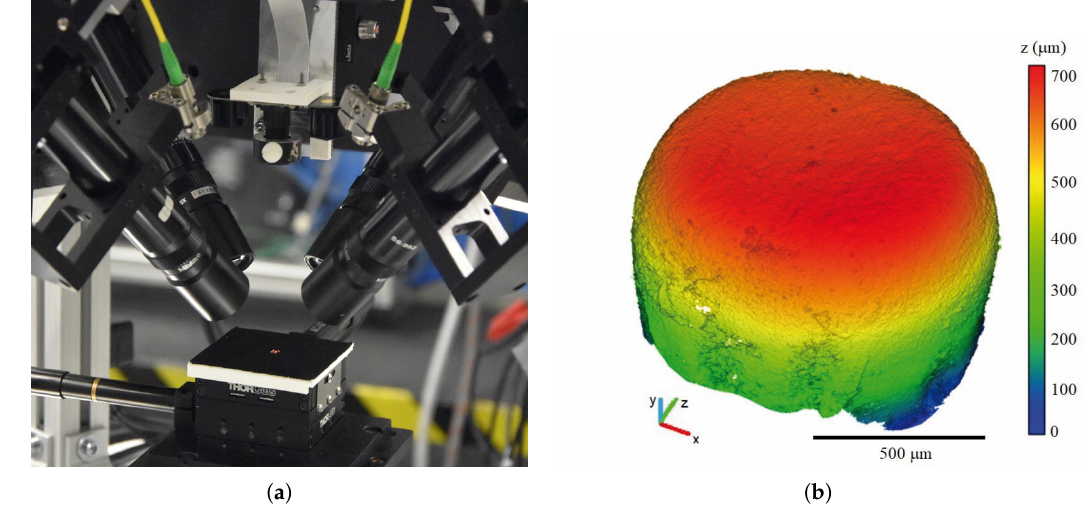
Figure 3. Digital holographic microscope for the inspection of micro cold formed micro cups: ( a ) The measurement system consists of 4 digital holographic microscopes to provide a full view of the top area of the object. ( b ) The measurement result shows a micro cup with diameter and height of approximately 1 mm. The lateral resolution is 2 µ m over an extended range of 700 µ m. The system can be used to quantify local imperfections, such as dents and deformations. The measurement uncertainty in the current configuration is 5 µ m. Reprinted according to Creative Commons license from Reference